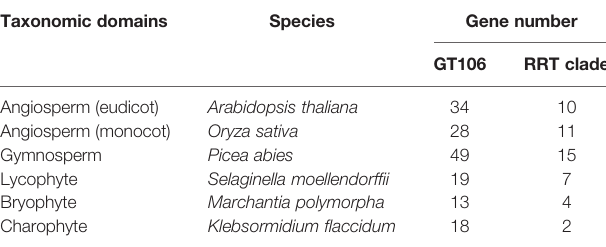
TABLE 1 | Gene numbers of GT106 and the RRT clade in plant genomes. Taxonomic